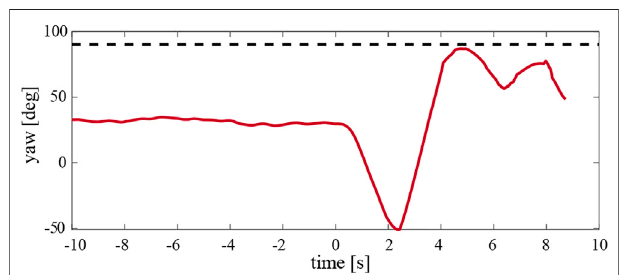
FIGURE15| Thetemporaldynamicsoftheyawangleofthehybridcase whereby the proportional term of the yaw control loop was reduced by 50%. This resulted in the stable hover and produced passive yaw torque. The robot had a 4 cm mass displacement con fi guration and encountered a side windof1.5 m/s.The90 ° yawangle,whichcorrespondstorobot fl yingintothe wind, is shown by the black dashed line.